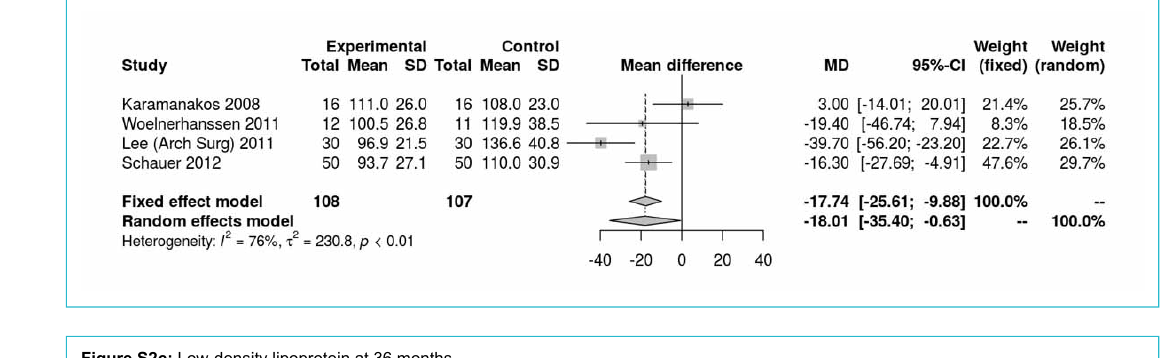
Figure S2b: Low-density lipoprotein at 12 months.